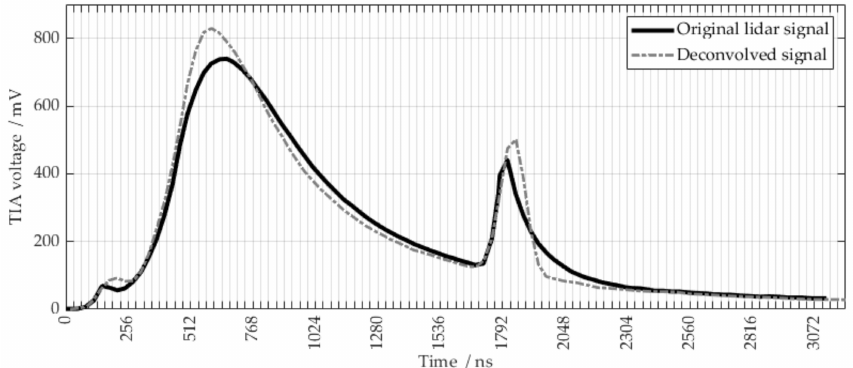
Figure 6. Sample of one of the 16 electronic outputs of the TIA (black bold). The abscissa shows the 32 ns sample rate. This signal is deconvolved with a Gaussian deconvolution routine for an effective range resolution of 30 m. The first pulse shows the onset due to the overlap function, then the 1/R 2 -decline. The second pulse is the laser reference inserted with the fiber delay line (Figure 5.7a of